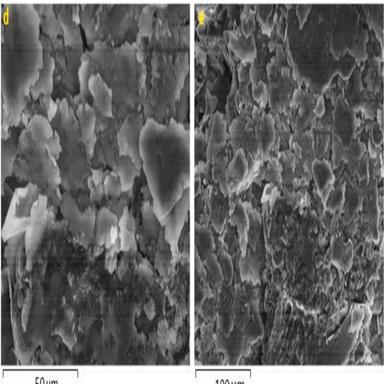
SEM images of EP (a,b,c) and EP/RT27 composite (d,e).